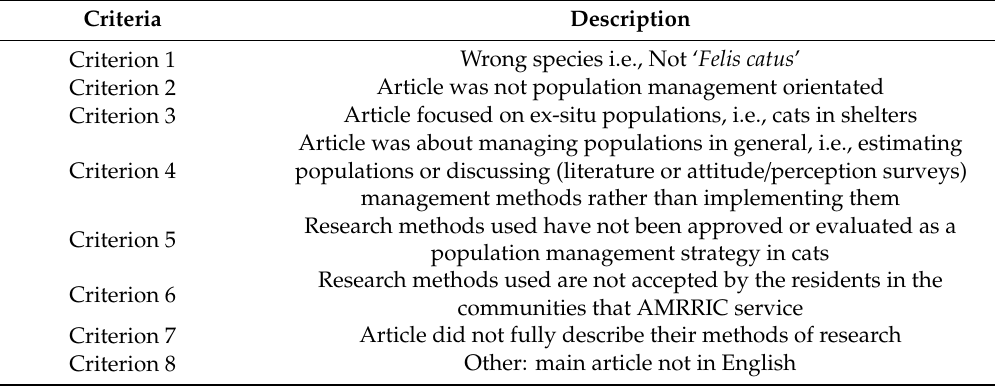
Table 1. Descriptions of the eight criteria for inclusion / exclusion of articles to systemically review current global cat population management practices potentially suitable for the remote Indigenous communities in Australia.